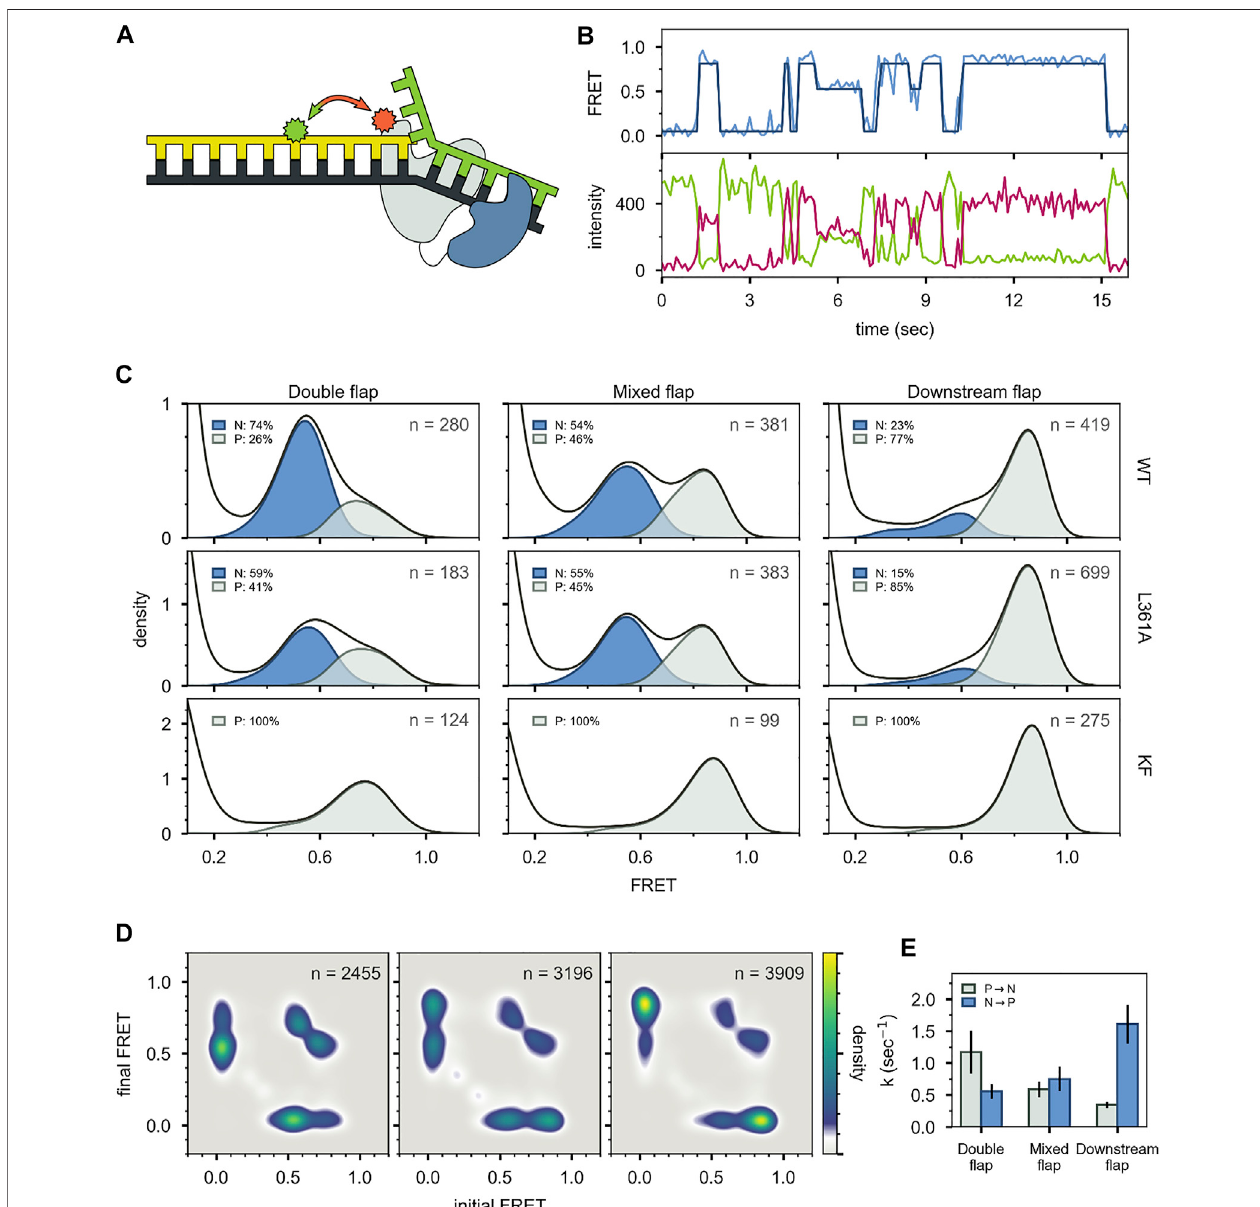
FIGURE9| smFRETdataforPolI — DNAcomplexesobtainedusinglabeling. (A) Locationsofdonor(green)andacceptor(red).Polymerasecoreisgreyand 5 ′ nuc domain isblue. (B) Donorintensity(green), acceptor intensity (red) and FRET ef fi ciency (blue)trajectories areshown.Theblack lineisa fi tfromHidden Markov modeling. (C) FRETef fi ciencyhistograms compiledfromntrajectories, separatedintostatesPandN. (D) Transitionprobabilitydensity plots,compiledfromntransitions.Fromleft to right: double fl ap DNA, mixed fl ap DNA and downstream fl ap DNA. (E) Rate constants for intramolecular transitions between states P and N. Reproduced from reference (Pauszek et al., 2021) with